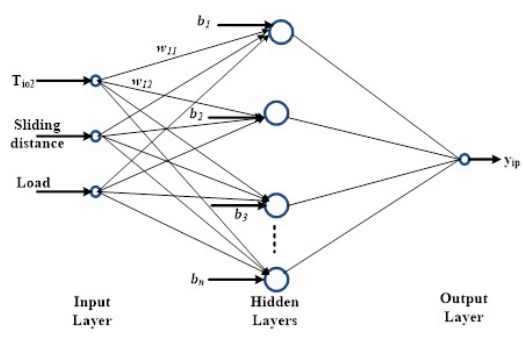
Figure 13. ANN structure